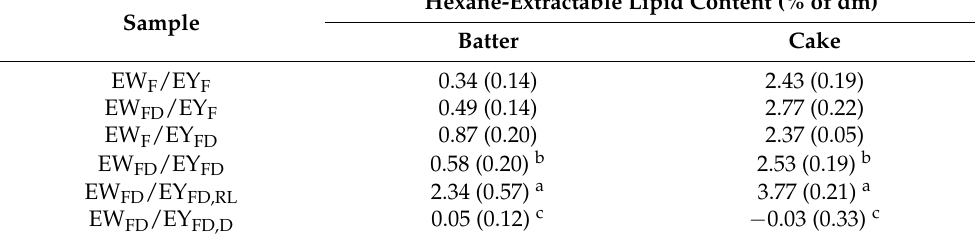
Table 3. Hexane-extractable lipid content (expressed as a % of sample dry matter (dm)) of sponge cake (batter) samples prepared from recipes containing different egg white and/or egg yolk treatments prior to batter preparation. Sample codes are shown in Table 1. Standard deviations are indicated between